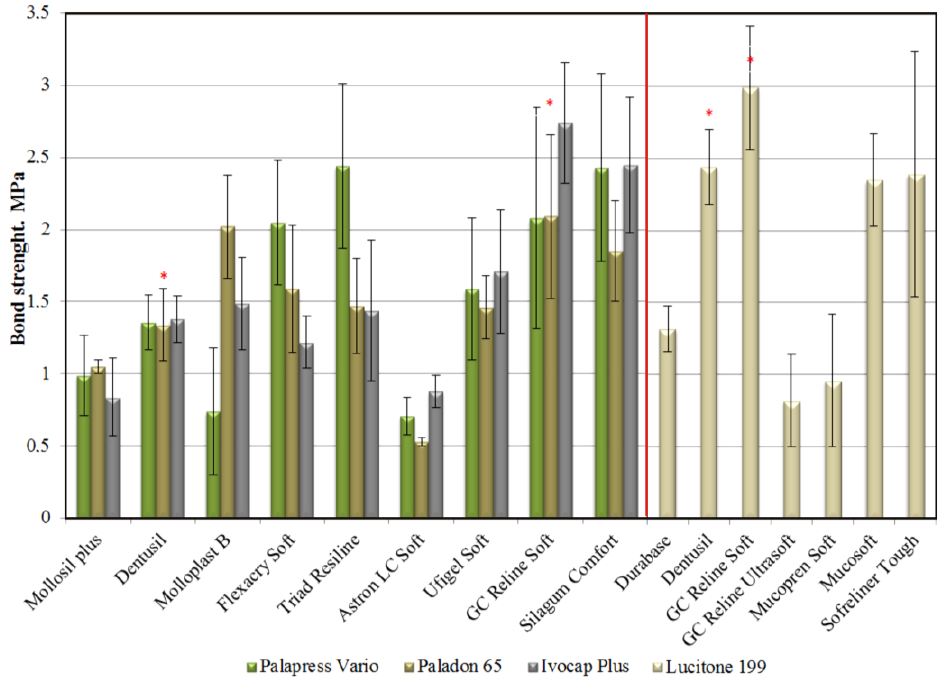
Figure 4. The tensile bond strength values obtained by Mutluay et al. [70] (left side), according to the ASTM standard, and by Kim et al. [63] (right side), according to the ISO standard. The diagram illustrates the differentiation of the results obtained using a similar methodology. The stars indicate the same LTSDL materials. The differences were